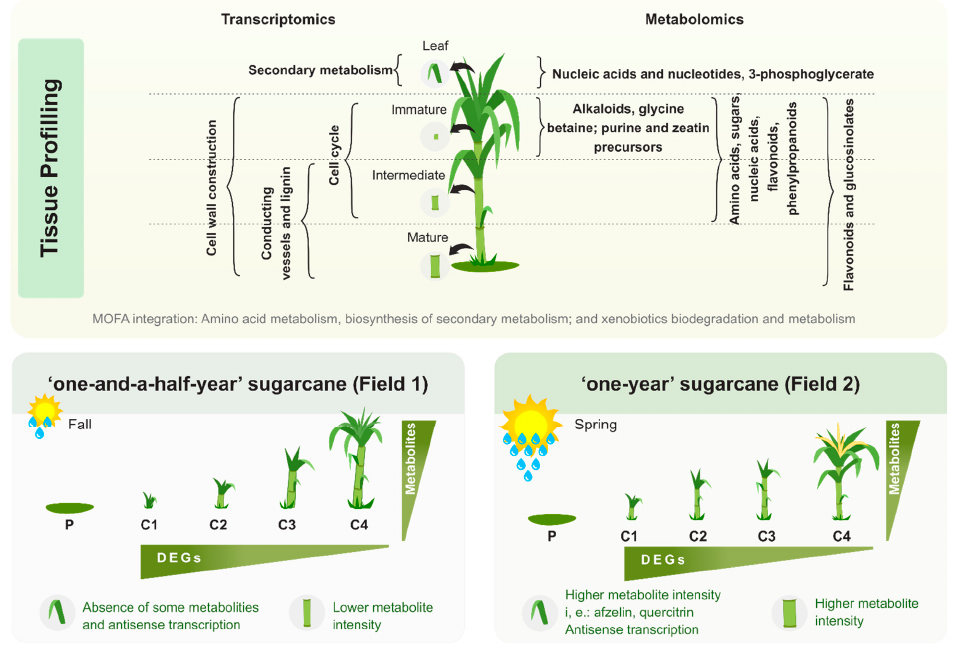
Figure 9. Two plantings of SP80-3280 were carried out in two seasons of the year with different climatic conditions that resulted in the “one-and-a-half-year sugarcane” (Field 1) and “one-year sugarcane” (Field 2) with differences in the plant width, height, brix content and ripening time. A systems biology approach was taken to study sugarcane development including physiological, morphological, agrotechnological, transcriptomics, and metabolomics analyses in plants with 4 (C1), 8 (C2), 11 (C3), and 13 (C4)-months after planting (P) in the leaf +1, immature, intermediate and mature internodes. The number of differentially expressed genes (DEGs) decreased during plant development (from C1 to C4) and the number of metabolites identified decreased from L1 to I9. Most of the variation found within the transcriptomics and metabolomics profiles is attributed to the differences among the distinct anatomical tissues and a summary of the